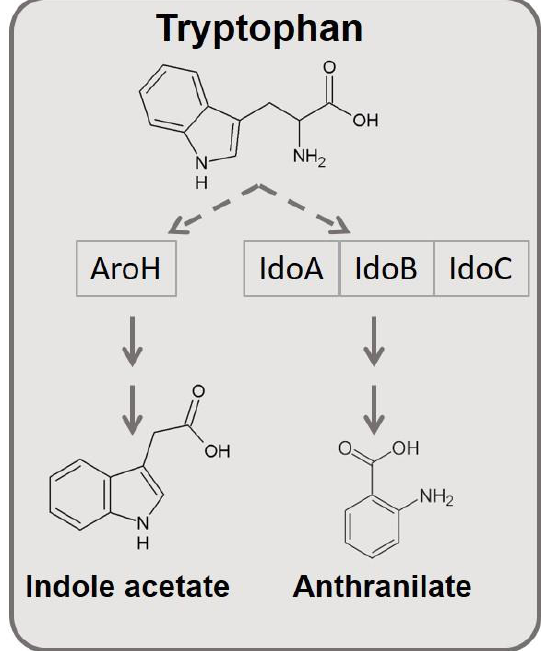
Figure 1. Known literature-based interactions between catabolic axis and the amino acid Trp in A. fumigatus.